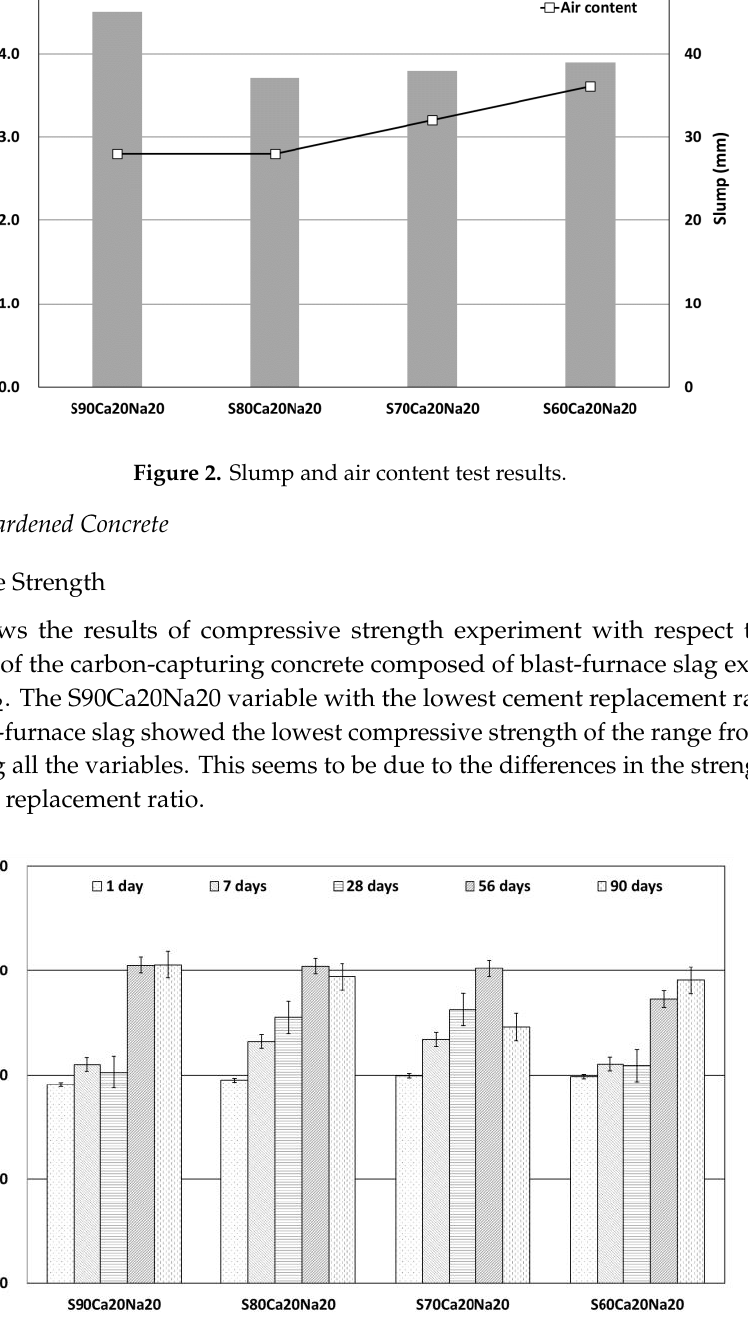
Figure 3. Compressive strength experiment results of high concentration CO 2 exposure conditions.